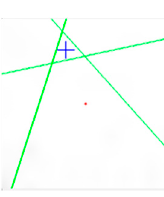
Figure 11. Using the distance between the center of the circle and the centroid of the nut to calculate concentricity. Blue indicates the center of gravity of the nut, green represents the connection of the midpoints of opposite sides, and red represents the center of the circle.